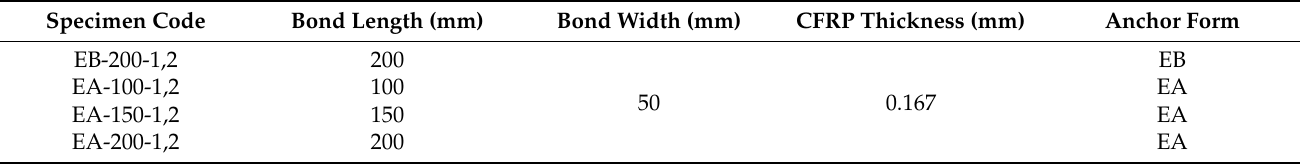
Table 1. Information of